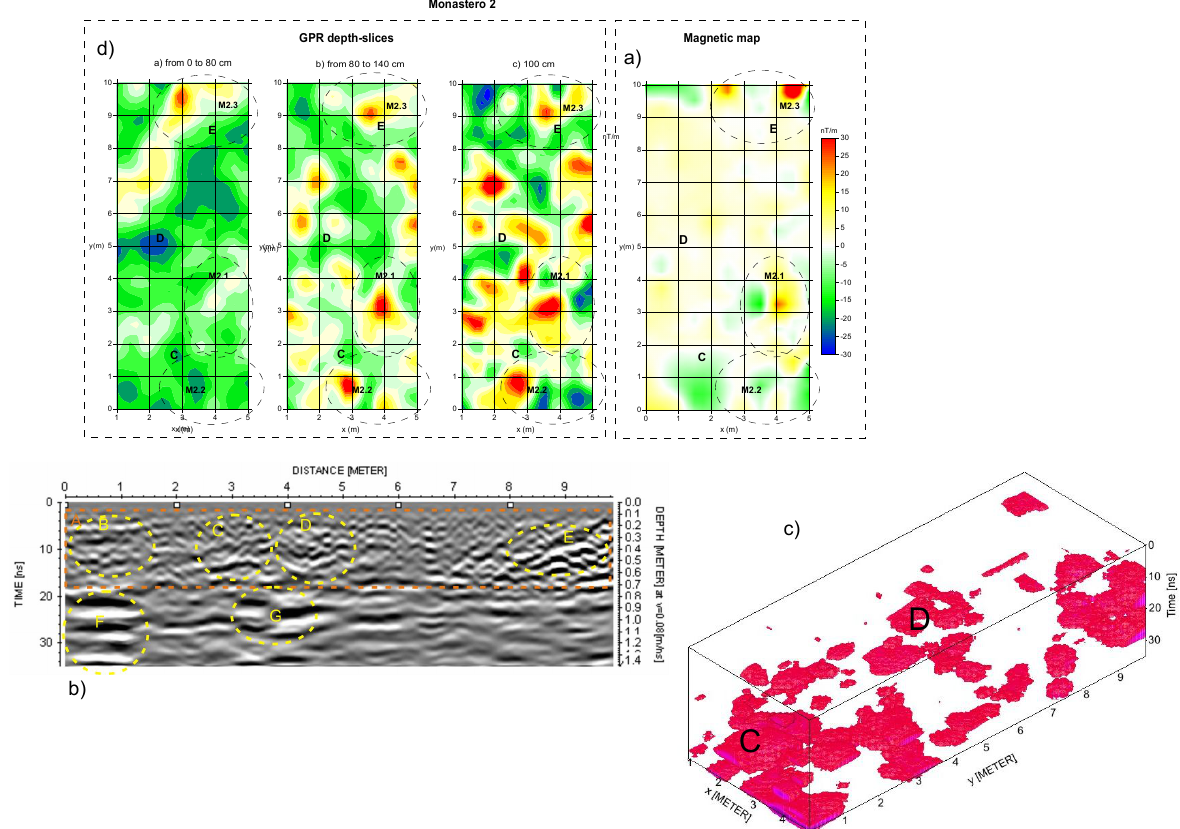
Fig. 6. Geophysical data acquired in “Monastero 2” site. (a) magnetic map; (b) radargram; (c) GPR data volume; (d) depth-slices built from 0 to 80cm of depth, from 80cm to 140cm of depth and at 100cm of depth. Labels explanation in the